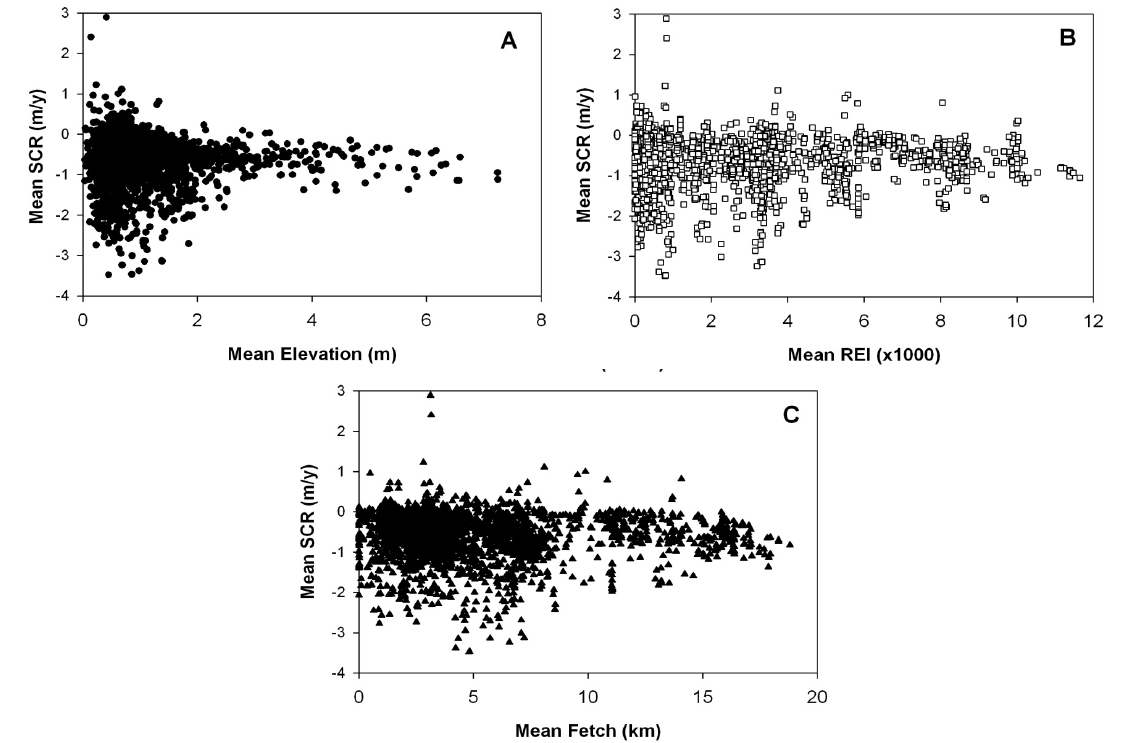
Figure 4. Scatterplots of (A) shoreline-change rates and mean elevation, (B) relative exposure index, and (C) mean fetch values calculated at 50 m spacing along the Neuse River Estuary